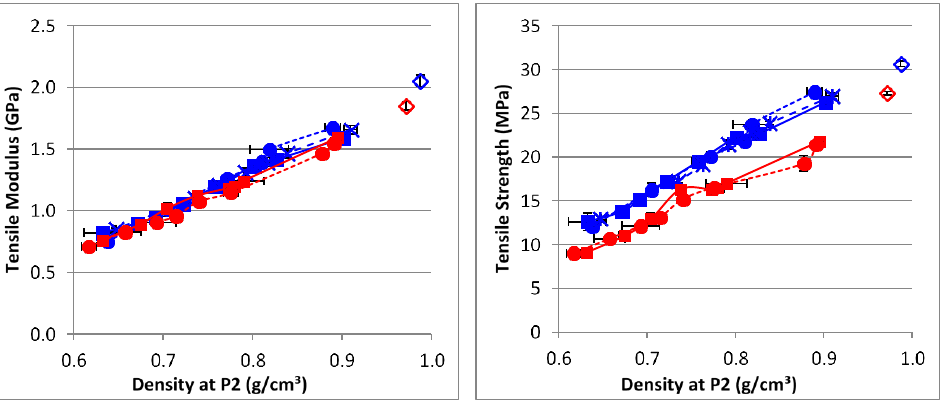
Figure 5. Dependence of the tensile modulus ( left ) and tensile strength ( right ) on the density of the foamed parts. Legend: PPCell, PPWood. Compact samples— ; samples N03_T60— , dashed line; samples N06_T60— , solid lines; samples N06_T40— , dotted lines. Error bars show 95% confidence interval. If not visible, error bars lie within the size of the used symbol for the respective sample.